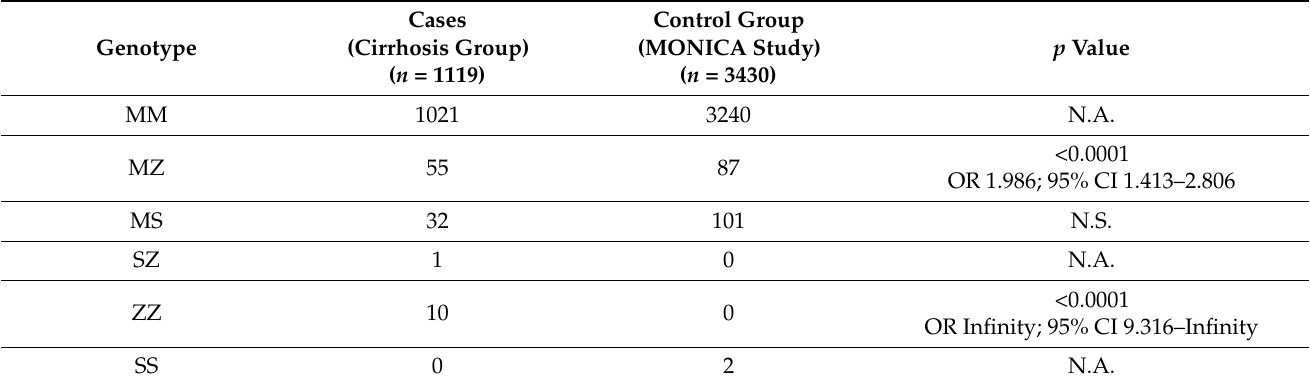
Table 1. SERPINA1 genotype frequency in cases and in